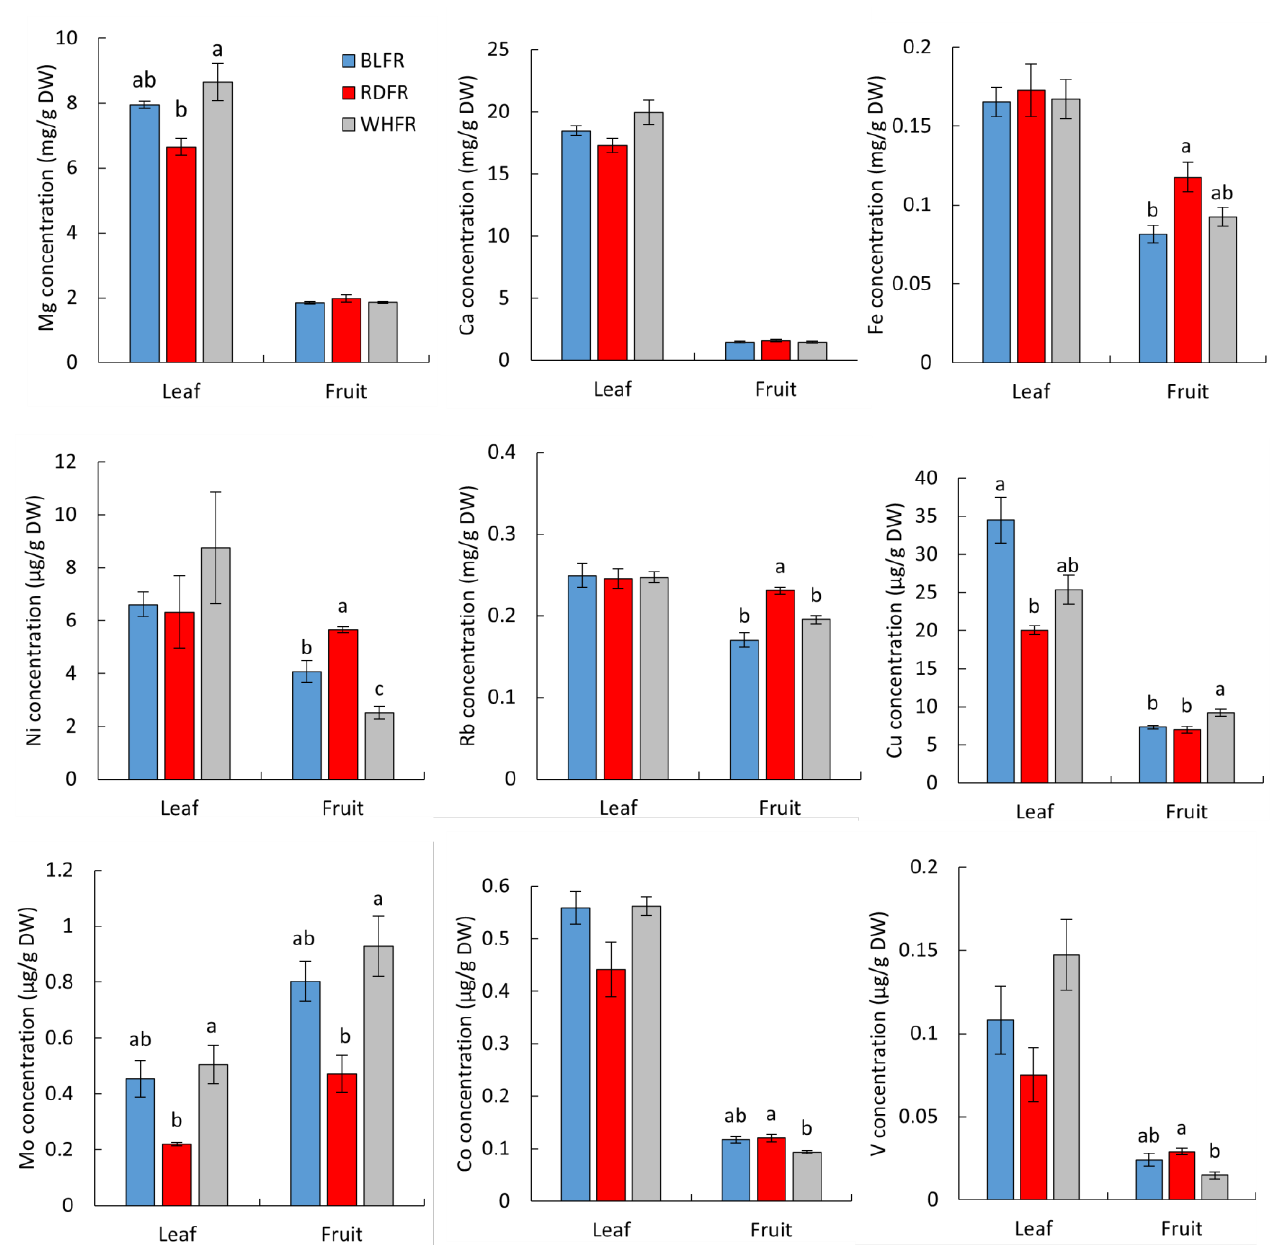
Figure 7. Mg, Ca, Fe, Ni, Rb, Cu, Mo, Co, and V concentrations of leaves and fruits treated with different lights. Values indicate the mean ± SE ( n = 3). Different letters indicate significant differences at p < 0.05 by Tukey-Kramer’s test. BLFR, RDFR, and WHFR refer to blue, red, and white light treatments,